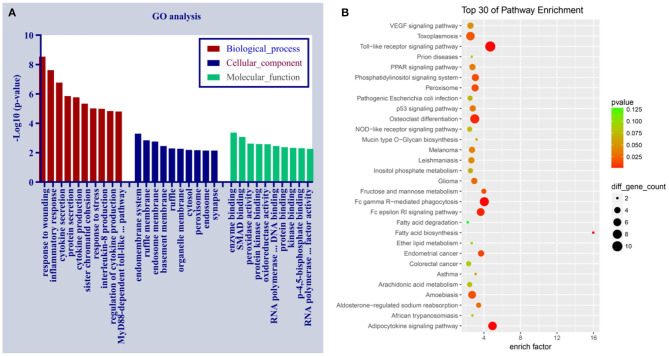
Gene Ontology and the Kyoto Encyclopedia of Genes and Genomes pathway analyses of dysregulated circRNAs in pediatric dilated cardiomyopathy (PDCM). (A) Ten most enriched gene ontology terms in biological process, cellular component, and molecular function for differentially expressed circRNAs. (B) Top 30 Kyoto Encyclopedia of Gene and Genome pathways of dysregulated circRNAs. EGFR, epidermal growth factor receptor.